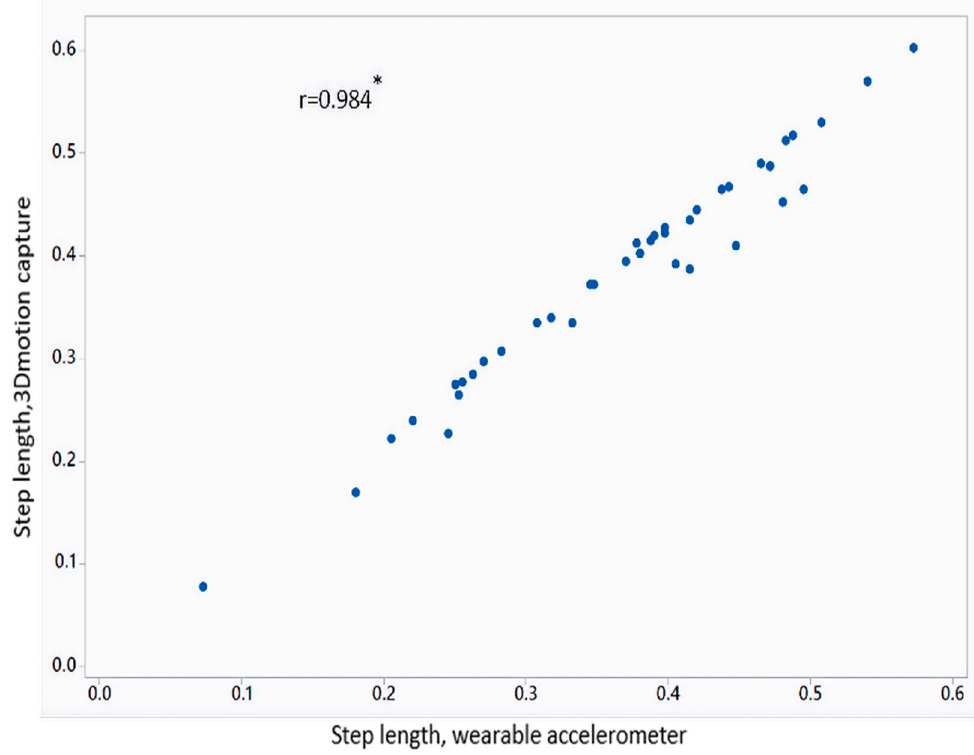
Figure 7. Correlation plot of step length estimated from wearable accelerometer-based approach and 3D motion capture system (* p < 0.01).